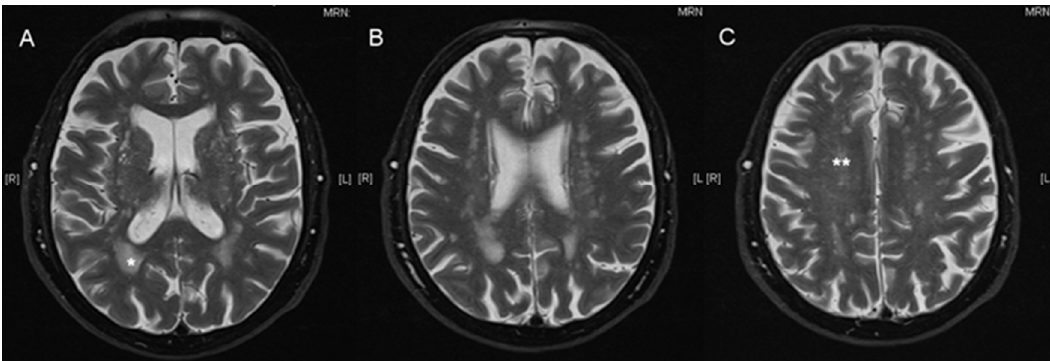
Figure 1. Exemplary MRI scan with annotated Fazekas score. Axial, T2 weighted cerebral MRI scan of an 87-year-old male patient before cochlear implantation with a Fazekas total score of 5, one asterisk indicates periventricular white matter lesions (PVWM *) score of 2; two asterisks indicate deep white matter lesions (DWM **) score of 3 (axial, A – C ).